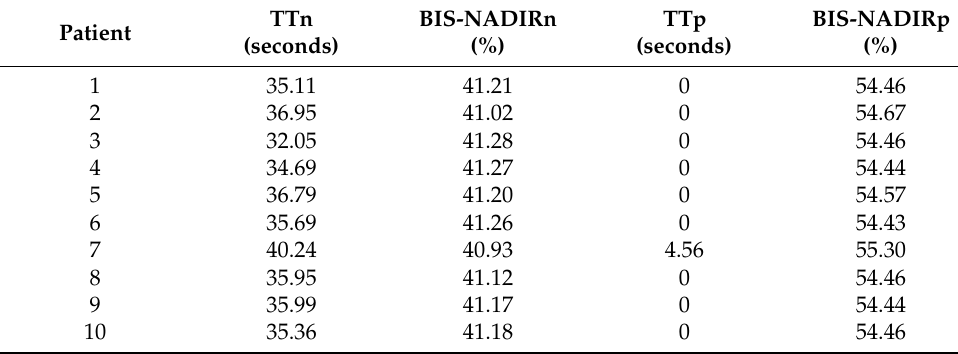
Figure 11. Disturbance rejection with the proposed FO-PI on all 24 patients—simulation results for the BIS maintenance phase. Table 4. Disturbance rejection performances for each patient.